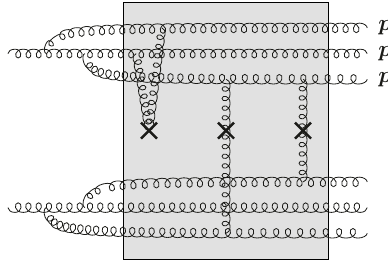
Figure 4 . Some contribution to the ‘3-jet’ cross section g + A